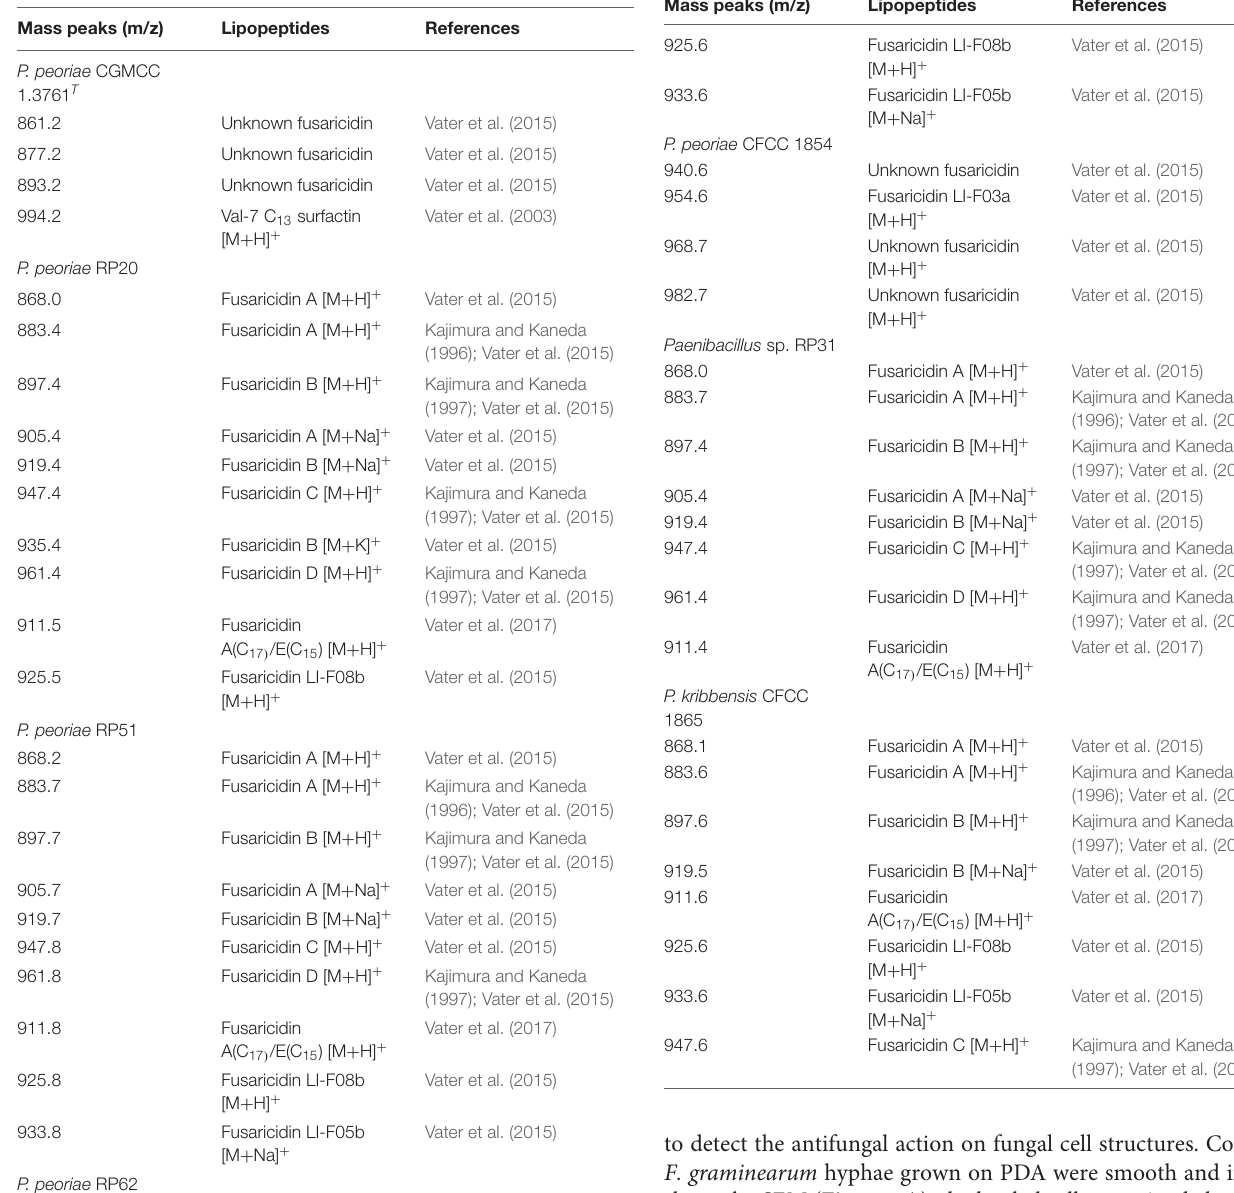
to detect the antifungal action on fungal cell structures. Control F. graminearum hyphae grown on PDA were smooth and intact shown by SEM ( Figure 4A ); the hyphal cells contained electron- dense cell contents and electron-lucent lipid granules shown by TEM ( Figure 4C ). In contrast, the hypha of F. graminearum confronting RP51 were shrunk and distorted ( Figure 4B ); hyphal cell walls were broken while cell contents were leaked indicating by vacuolization ( Figure 4D